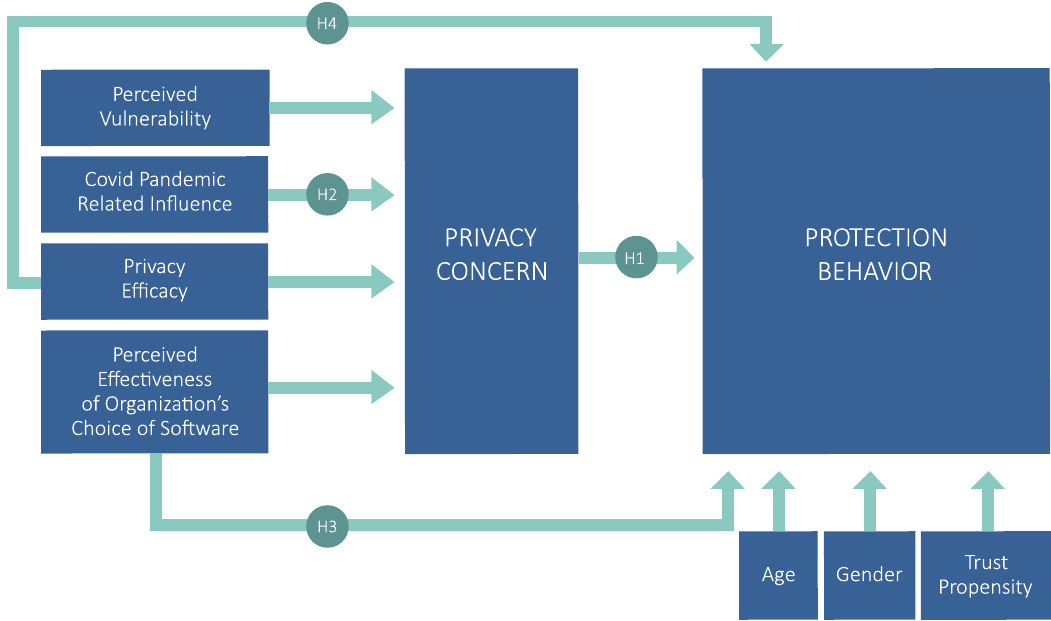
Figure 1. Hypothesized structural